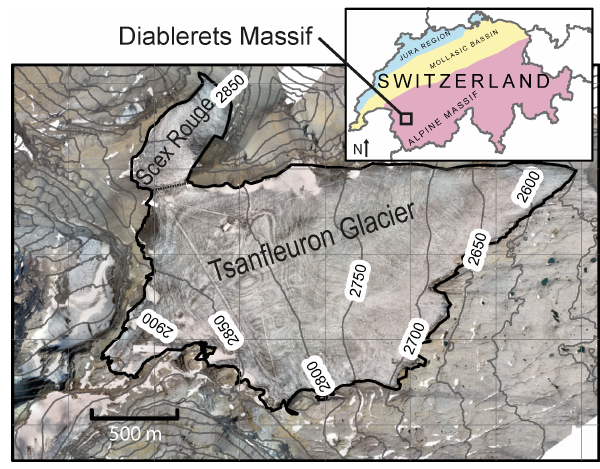
Figure 1. Aerial image and digital elevation model captured from drone images of the Tsanfleuron Glacier,